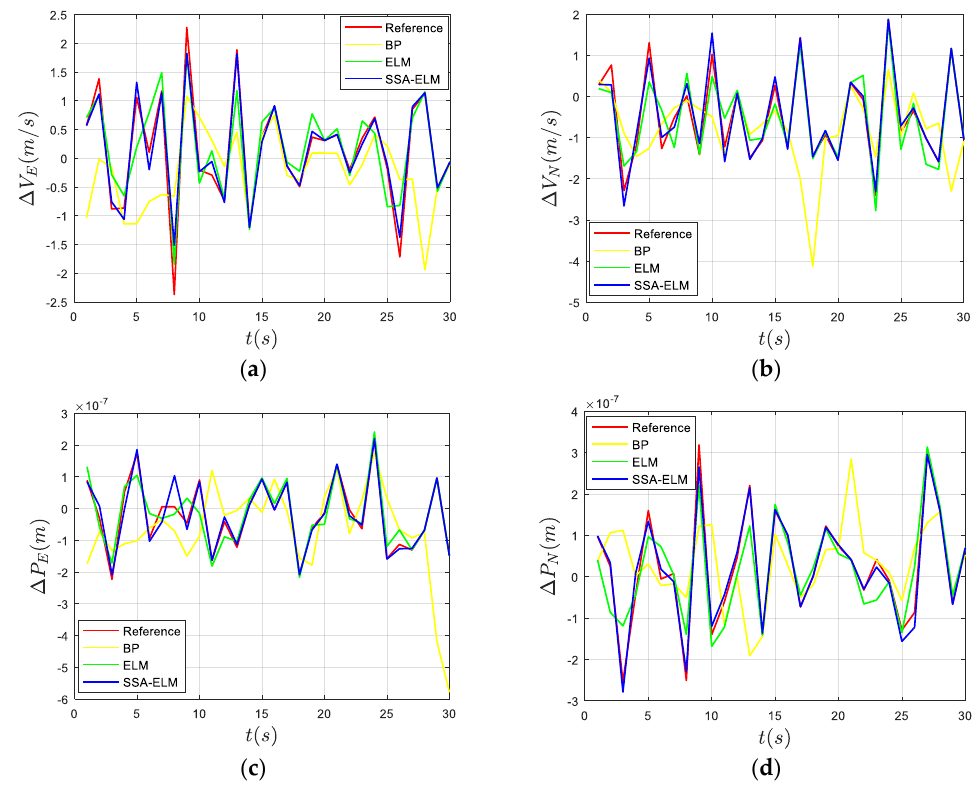
Figure 9. Prediction of the velocity and position differences of different methods during the first interruption: ( a ) east velocity difference prediction; ( b ) north velocity difference prediction; ( c ) east position difference prediction; ( d ) north position difference prediction. Table 6. RMSE and MAE of the velocity and position differences of different methods during the first interruption.